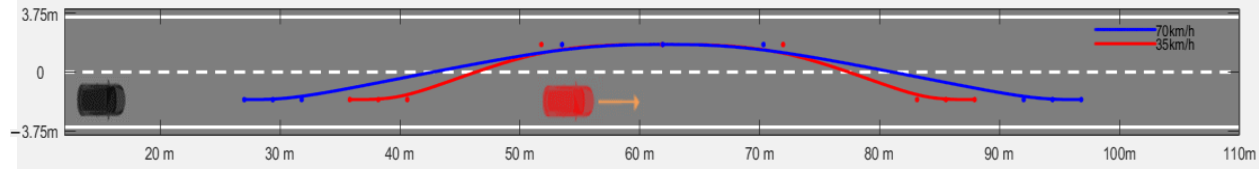
Figure 7. The vehicle has a constant speed of 35 km/h and 70 km/h to avoid small low-speed obstacles.